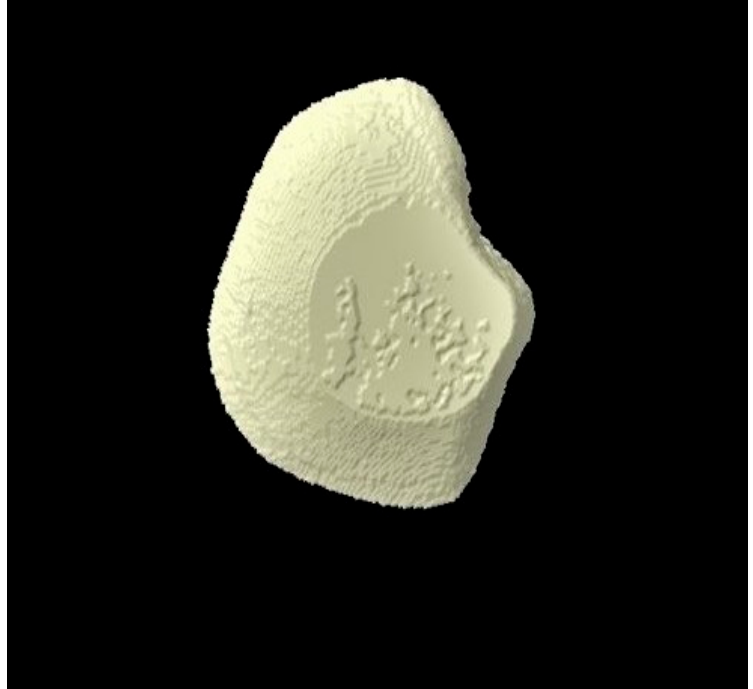
Figure 9. Micro-CT image of group 3 samples presenting enamel surface post-demineralization.